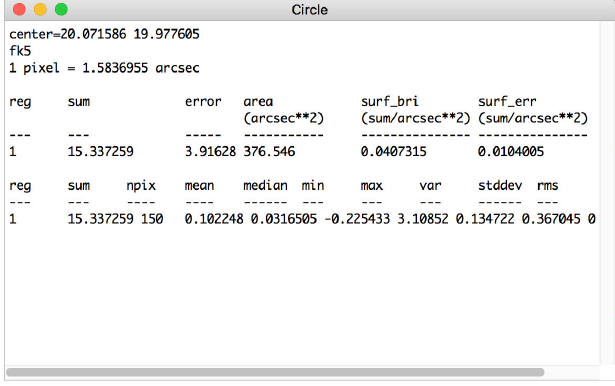
Fig. 46.— Statistics window for our